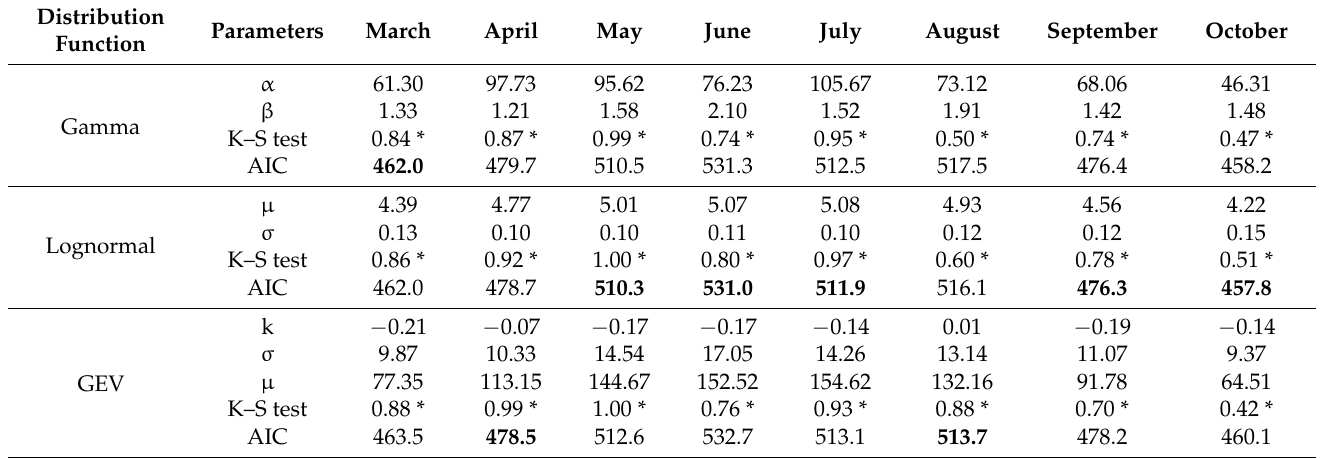
AIC values in bold indicate the optimal distribution function according to Akaike information cri- terion, and * means passed the KS test at the 0.05 significance level.